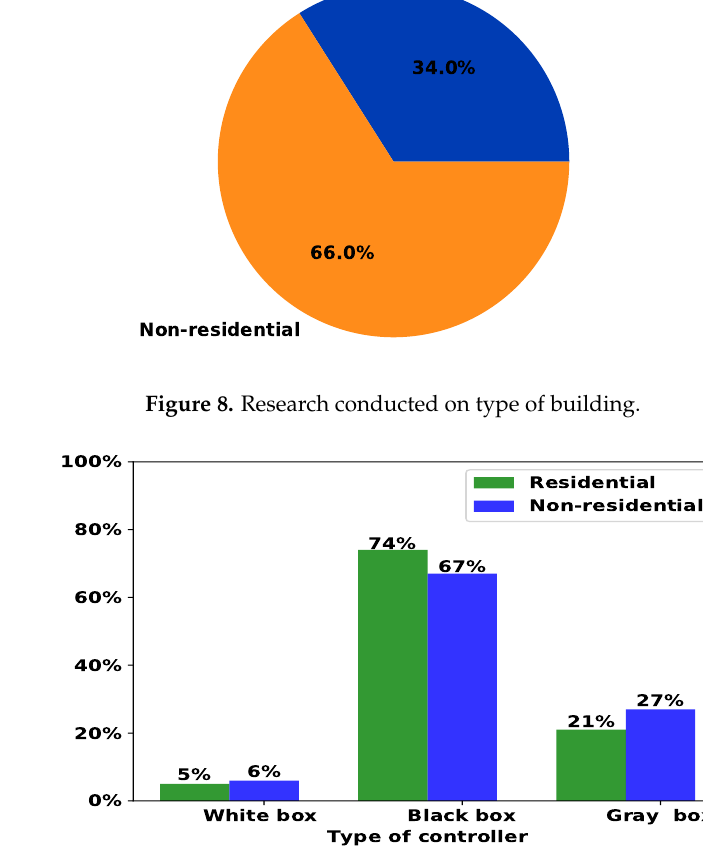
Figure 9. Controller application on both type of